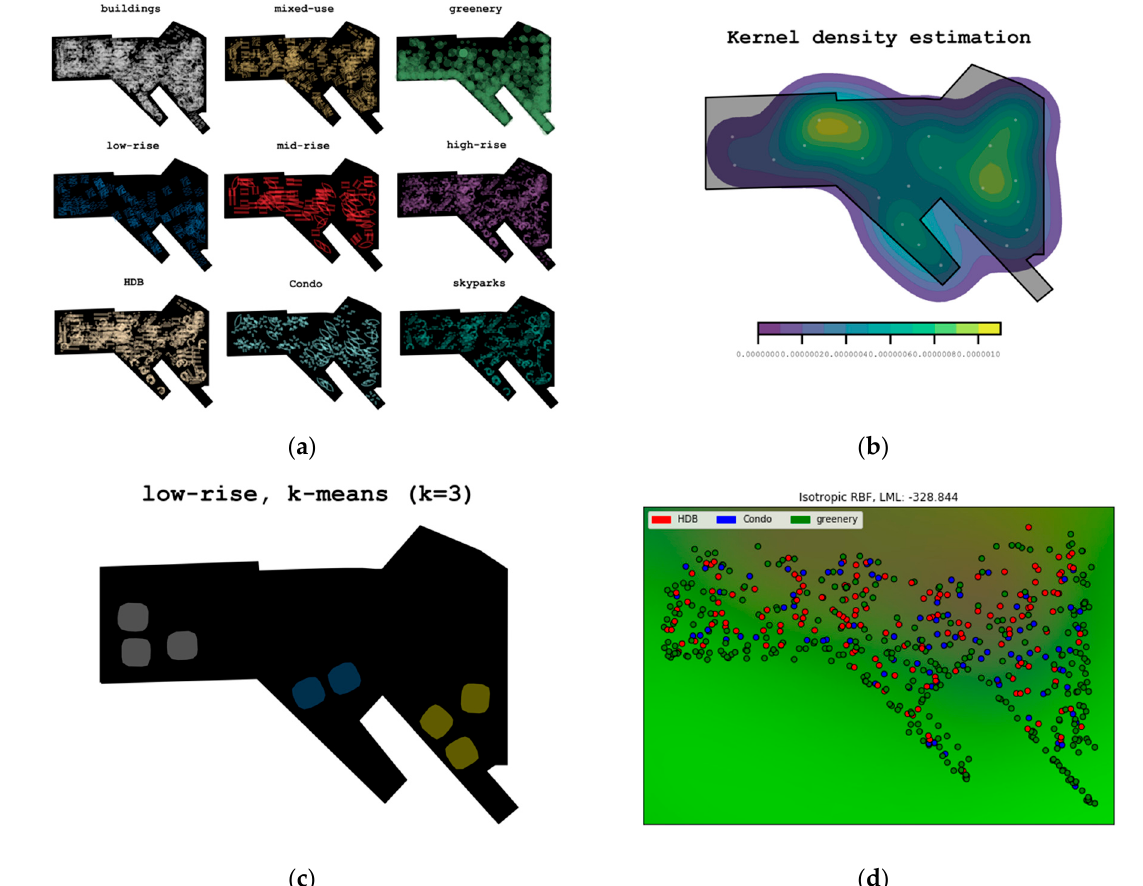
Figure 3. ( a ) Heatmap of all submissions separated by object groups. ( b ) Kernel density estimation with number of units as weight for an individual submission. ( c ) Clustering of objects with k-means (here: low-rise buildings) for an individual submission. ( d ) Gaussian process clustering for the object groups “HDB”, “Condo” and “greenery”.